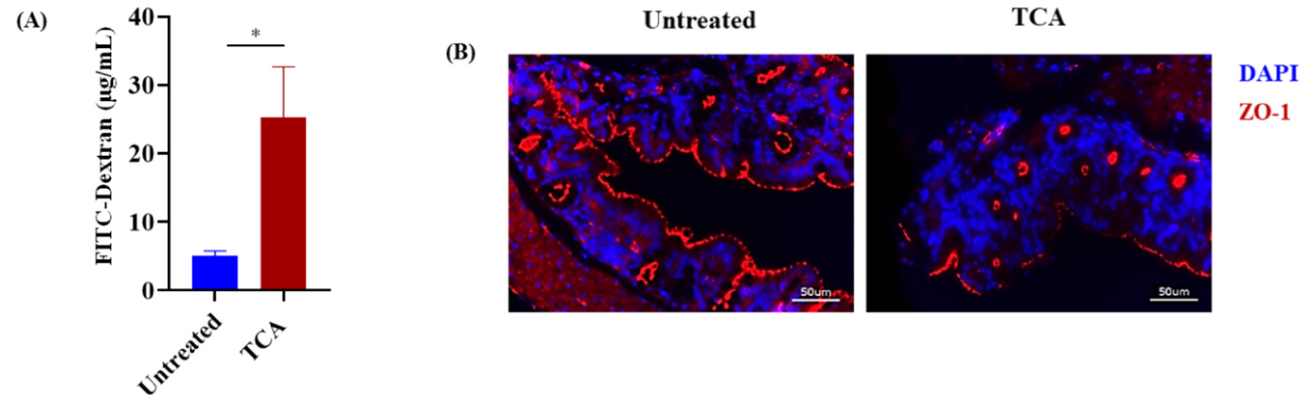
Figure 4. TCA increases intestinal permeability leading to fungal dissemination from the GI tract. ( A ) Gut permeability was measured in infected mice using a FITC-dextran assay. At 10 days post-infection, male and female BL57/6J mice in both control and TCA-treated groups infected with CA were given an oral gavage of 150 µL PBS containing 15 mg FITC-dextran. Four hours after administering FITC-dextran, mice were anesthetized, and blood was collected via retro-orbital bleed. Blood samples were processed via a two-fold serial dilution in a 96-well plate, and fluorescence was measured via a plate reader (excitation: 485 nm; emission: 520 nm). Data represent mean ± SEM. Statistical significance was evaluated using the Mann–Whitney U test. p values ≤ 0.05 (*) was considered statistically significant. ( B ) ZO-1 tight junction protein expression in untreated and TCA-treated mice. Colon tissue from untreated and TCA-treated mice from CA-infected mice (10 days post-infection) was stained with ZO-1 and DAPI antibodies. Representative images are shown here.